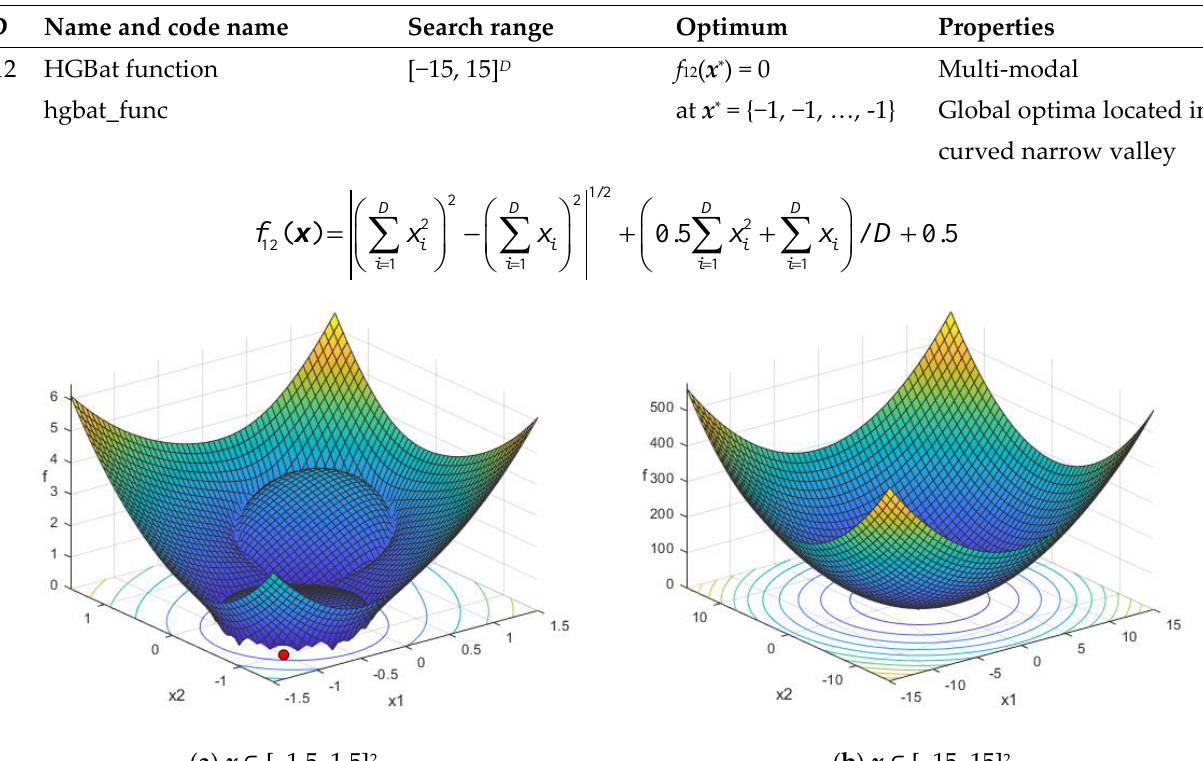
Figure A12. HGBat function in two dimensions.